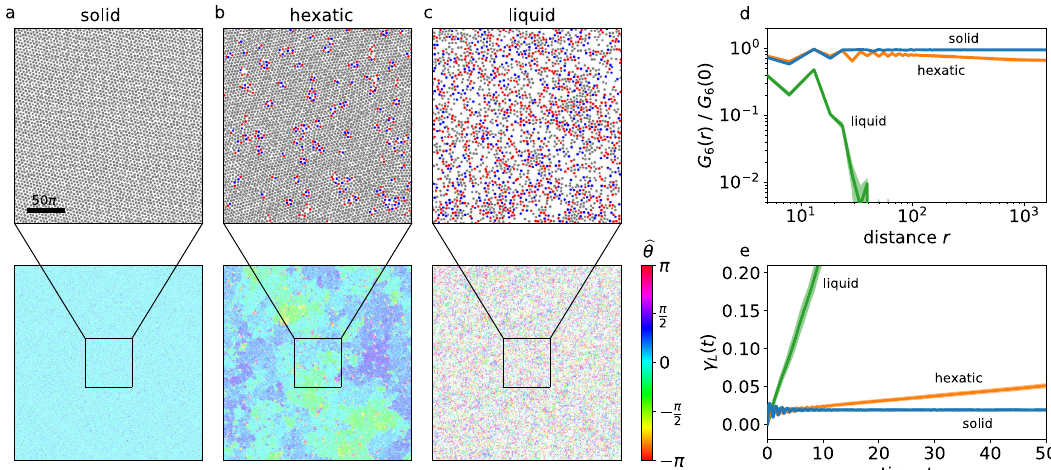
Fig. 2 Characterization of different phases on a L = 1000 π domain. Top row: Vortex cores (gray) and the locations of the 5-fold (red) and 7-fold (blue) defects in the ( a ) solid ( α = − 0.9, λ = 15), ( b ) hexatic ( α = − 0.75, λ = 7) and ( c ) liquid ( α = − 0.7, λ = 7) phases. The scale bar denotes a length of 50 π . Bottom row: The local orientational order, visualized by the deviation ^ θ from the mean orientation angle (Methods), becomes increasingly short-ranged from the solid, to the hexatic, and the liquid phases. ( d ) The orientational correlation function G 6 ( r ) remains constant in the solid phase, decays approximately algebraic in the hexatic phase and faster than algebraic in the liquid phase. ( e ) Dynamic Lindemann parameter γ L ( t ) as a function of time. γ L ( t ) remains approximately constant for the solid phase, whereas it diverges for both the hexatic and liquid phases. The envelope around each line signi fi es the standard deviation, calculated from six snapshots for ( d ) and six ensembles of vortex core trajectories for ( e ) from the same simulation at different